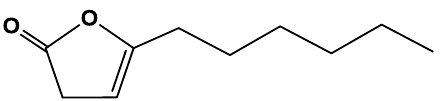
Figure 1. Chemical structure of 5-hexyl-3H-furan-2-one.